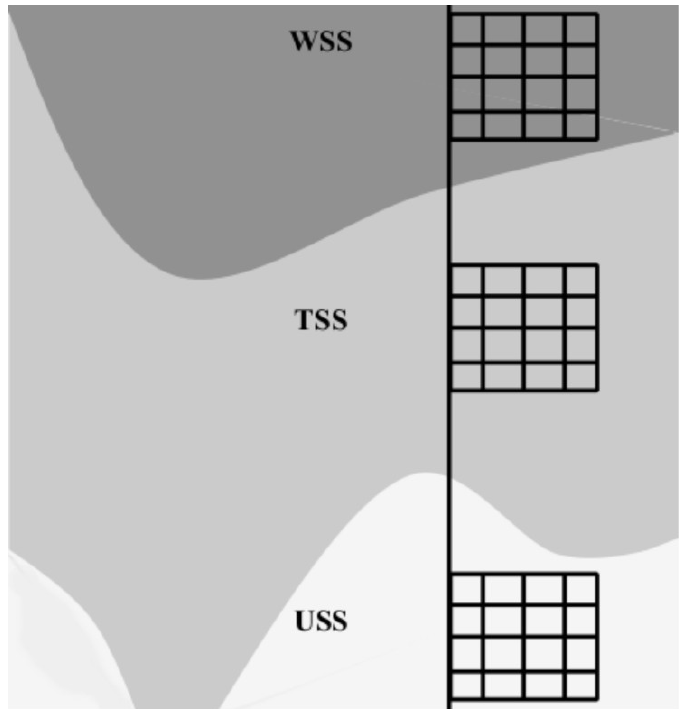
Figure 1. A layout of the study site in Macon County